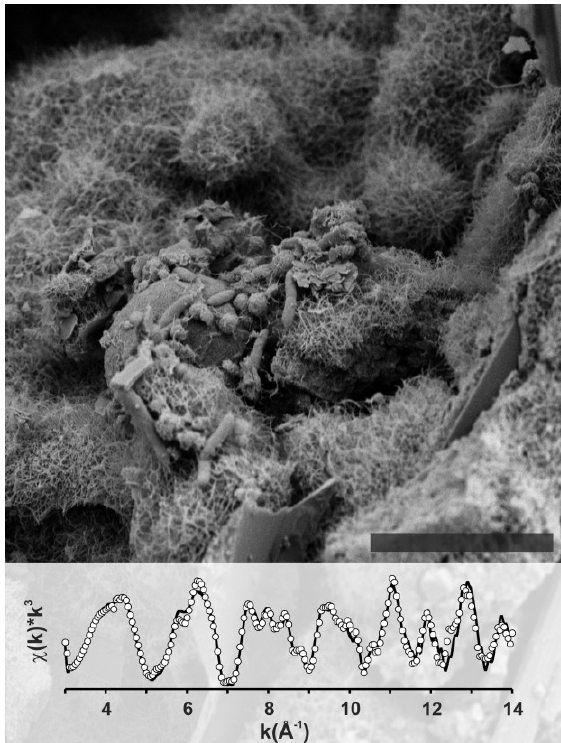
Figure 5. FE-SEM SE micrograph of microbially-colonized, secondary Fe-bearing mineral coating on surface of a sulfide-mineral clast from intrusive waste rock (FC-2-3A). Scale bar equals 5 µm. Corresponding bulk Fe K-edge extended X-ray absorption fine structure (EXAFS) spectra (solid line) and linear combination fitting (LCF) fit (circles) of sulfide-mineral weathering